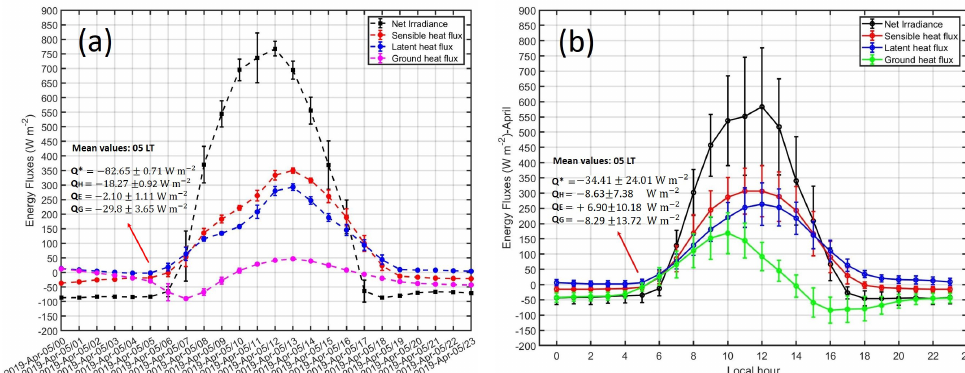
Figure 13. ( a ) Daily cycle of mean hourly values and standard deviations of the energy balance components on 05 April 2019: net irradiance (Q ∗ ), sensible heat flux (Q H ), latent heat flux (Q E ), and ground heat flux (Q G ). The mean hourly values of all components at 05 LT are shown. ( b ) Daily cycle of mean monthly values and standard deviations during April 2019 of the energy balance components. The mean monthly values of all components at 05 LT are